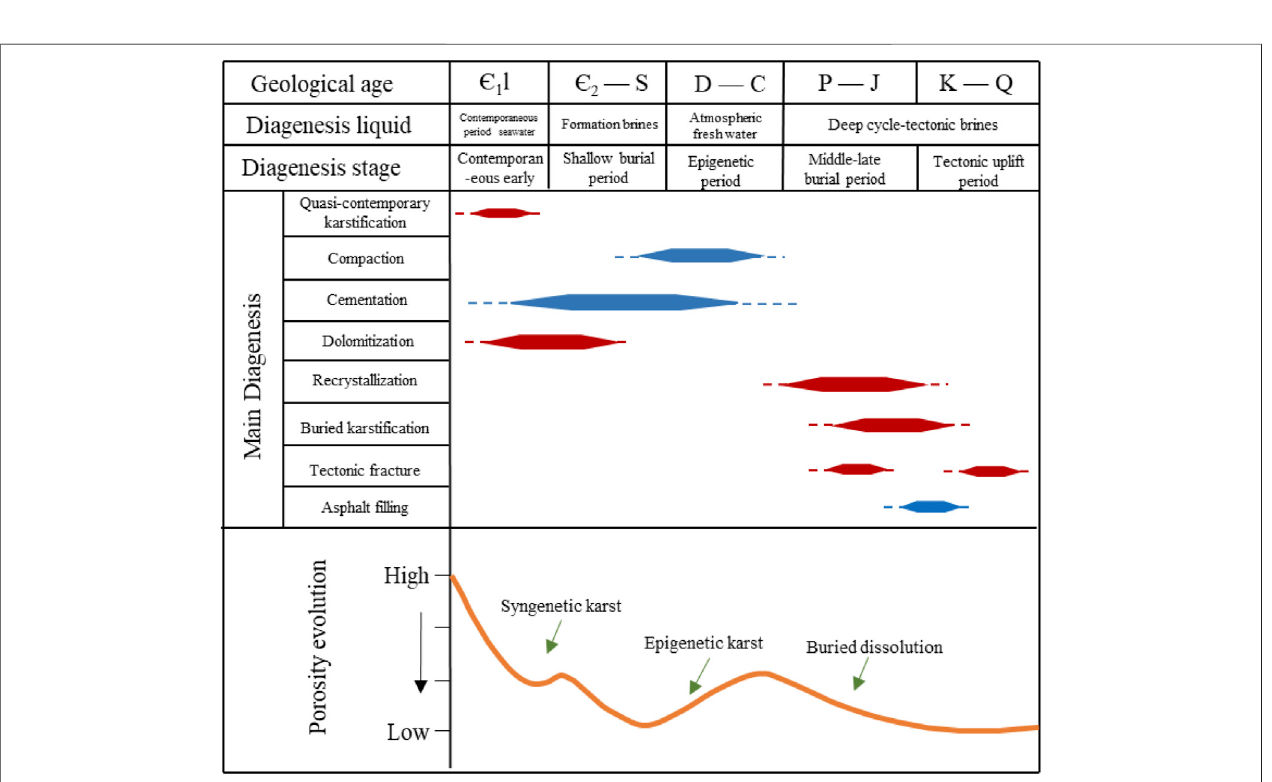
FIGURE 5 | The diagenetic sequence of the Longwangmiao Formation reservoir in the Sichuan Basin.